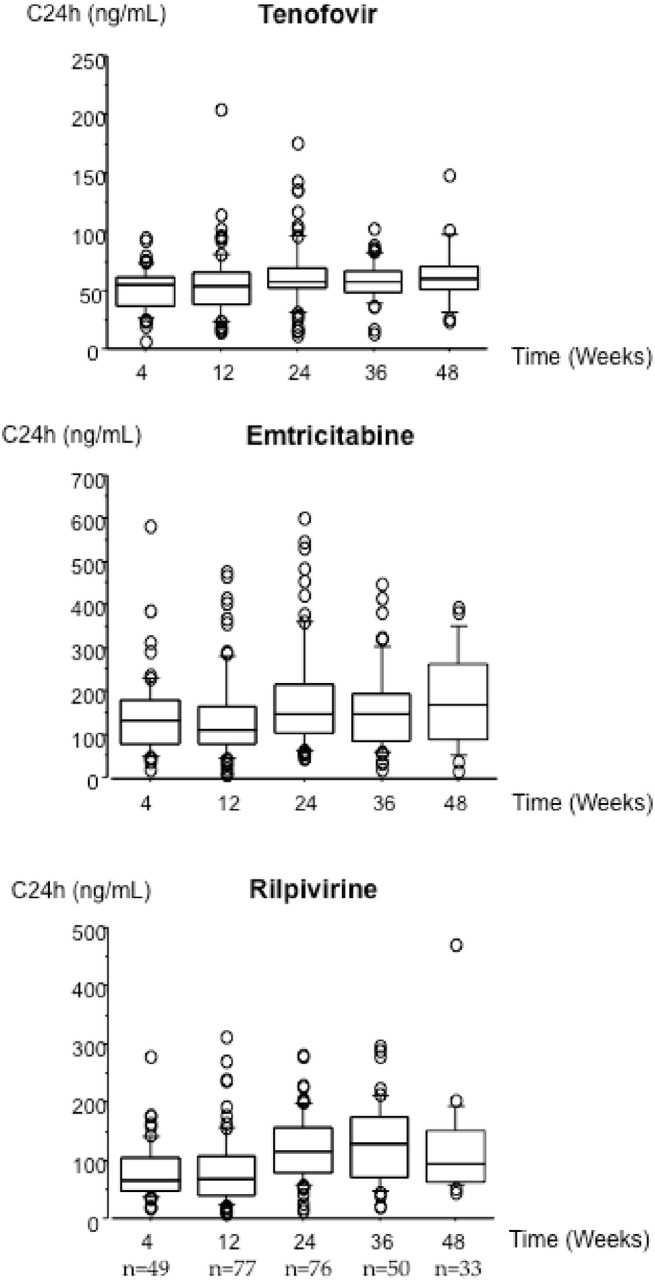
Distribution of tenofovir, emtricitabine and rilpivirine plasma concentrations at different time-points.